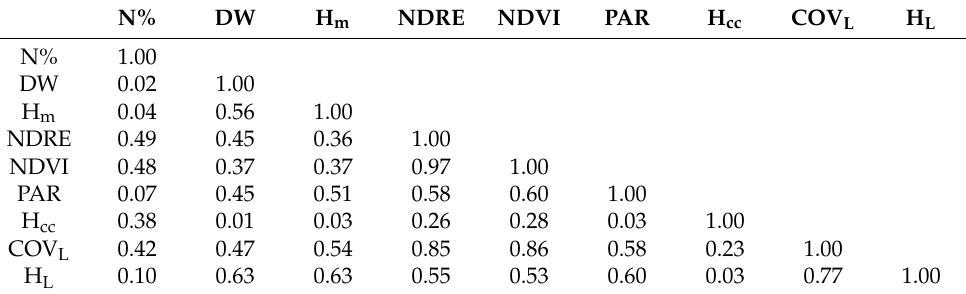
Figure 9. Relationships between measured and sensed crop parameters. Table 2. Coefficient of determination (R 2 ) for all paired combinations of variables.